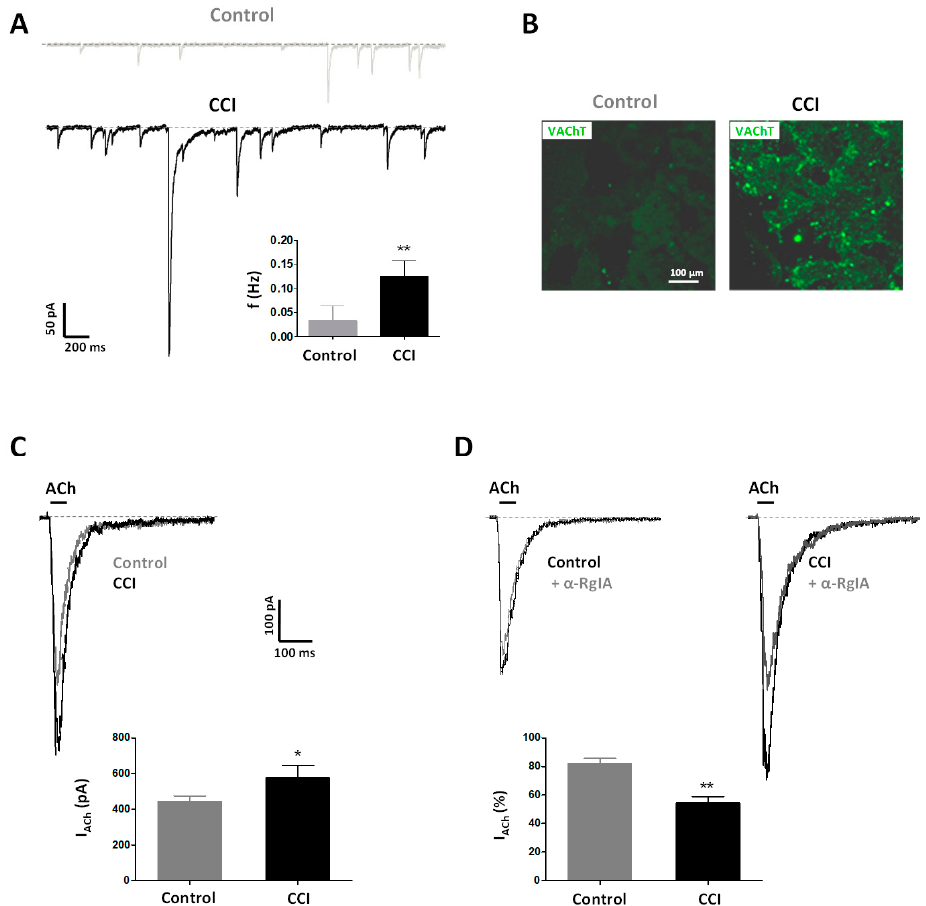
Figure 3. CCI animals show functional and structural remodeling of the splanchnic nerve–chromaffin cell junction. ( A ) sEPSCs recorded in chromaffin cells in tissue slices of the adrenal gland from Control and CCI animals. V h = − 80 mV. Inset . sEPSC frequency from Control ( n = 6 cells, 3 rats) and CCI ( n = 3 cells, 3 rats) animals. Statistical significance was assessed by a Student t test for unpaired data (**, p < 0.01). ( B ) Fluorescence confocal images of adrenal glands from Control and CCI animals stained for the vesicular acetylcholine transporter (VAChT). Images are representative of those obtained in 6 Control and 4 CCI animals. ( C ) Currents evoked by acetylcholine (ACh) in adrenal chromaffin cells from Control and CCI animals. ACh (100 µM) was applied during the time (50 ms) indicated by the horizontal bar. V h = − 80 mV. Inset . Peak amplitudes of currents evoked by ACh in chromaffin cells from Control ( n = 66 cells, 19 rats) and CCI ( n = 31 cells, 8 rats) animals. ( D ) Effect of α -RgIA on ACh-evoked currents in chromaffin cells from Control and CCI animals. ACh (100 µM, 50 ms) was applied as indicated by the horizontal bar in the absence and the presence of α -RgIA (+ α -RgIA, 200 nM, 2 min). V h = − 80 mV. Inset . Percentage of ACh-evoked currents remaining in the presence of α -RgIA from Control ( n = 20 cells, 6 rats) and CCI ( n = 4 cells, 1 rat) animals. Statistical significances were assessed by a Student t test for unpaired data (*, p < 0.05; **, p < 0.01). Scale bars are the same for panels ( C , D ). Resting membrane potential (V r ) was less negative in chromaffin cells from CCI animals ( − 43.5 ± 1.6 mV; n = 29 cells, 9 rats) than from Control ones ( − 50.0 ± 1.8 mV; n = 40 cells, 9 rats; p < 0.05) (Figure 4A). This possibly contributed to a higher frequency of spontaneous action potentials in cells from injured animals (1.7 ± 0.5 Hz; n = 5 cells, 2 rats) than from uninjured ones (1.1 ± 0.5 Hz; n = 11 cells, 5 rats; p < 0.01) (Figure 4B). Interestingly, no significant differences were observed in the